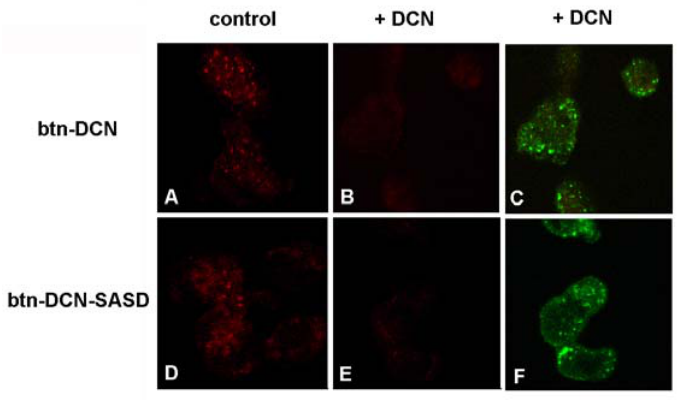
FIGURE 4. Internalization of btn-DCN and btn-DCN-SASD is specifically blocked by unlabeled decorin. Decorin purified by HPLC-DEAE was biotinylated and conjugated to SASD as described above. Human skin fibroblasts were incubated on ice for 30 min in the presence (B,C,E,F) or absence (A,D) of 75 µg/ml unlabeled decorin in endocytosis medium, followed by an addition of 5.2 µg/ml of btn-DCN (A-C) or btn-DCN-SASD (D-F) for 30 min. Cells were washed and incubated for 10 min with ligand-free medium at 37°C. Cells were trypsinized and stained for biotinylated decorin using Alexa555-conjugated strepavidin, or for the endosomal protein EEA1 (C,F, green Alexa488 fluorescence) followed by confocal scanning microscopy. Unlabeled decorin efficiently competed for uptake of both btn-DCN and btn-DCN-